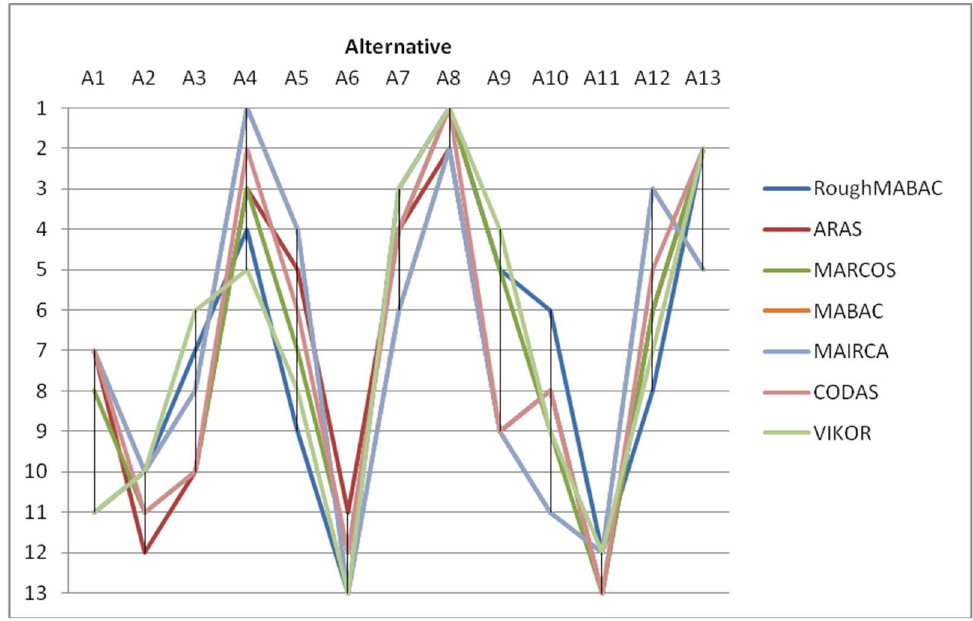
Figure 4. Rank of alternatives by applying other MCDM methods.